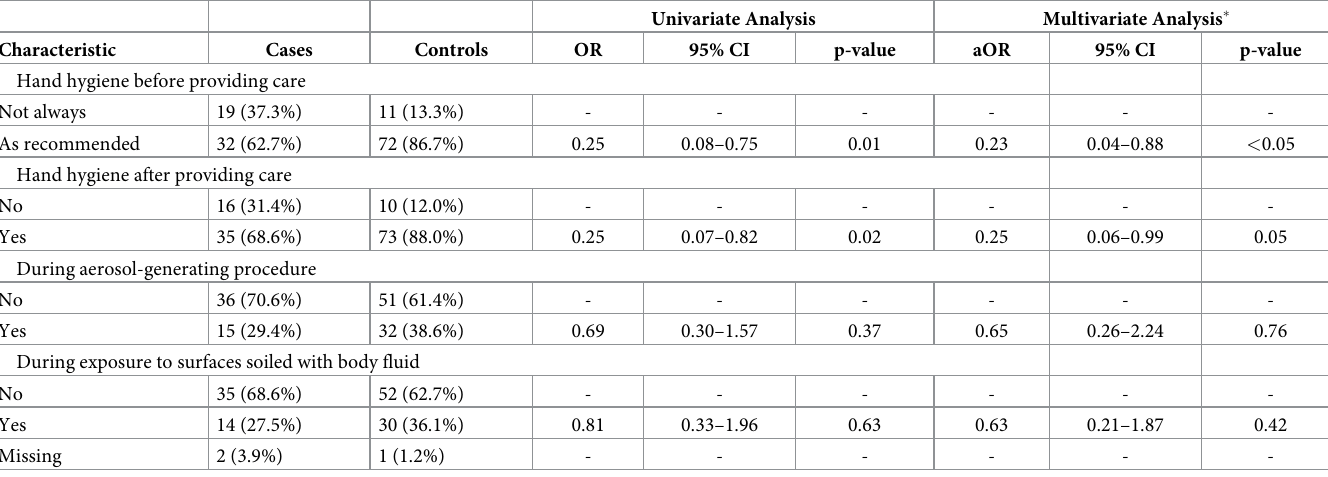
Table 2. Associations between individual IPC practices during contact within 1 metre and SARS-CoV-2